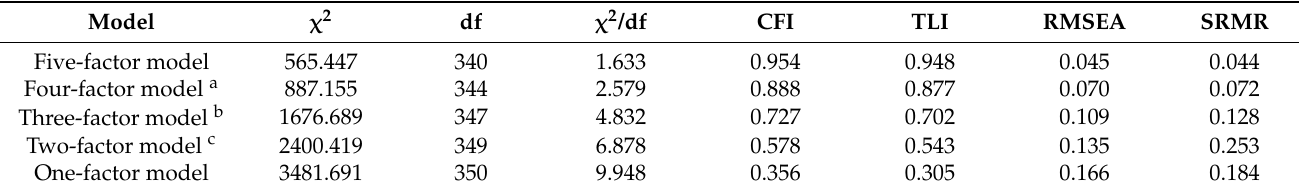
Table 2. Confirmatory factor analysis results.